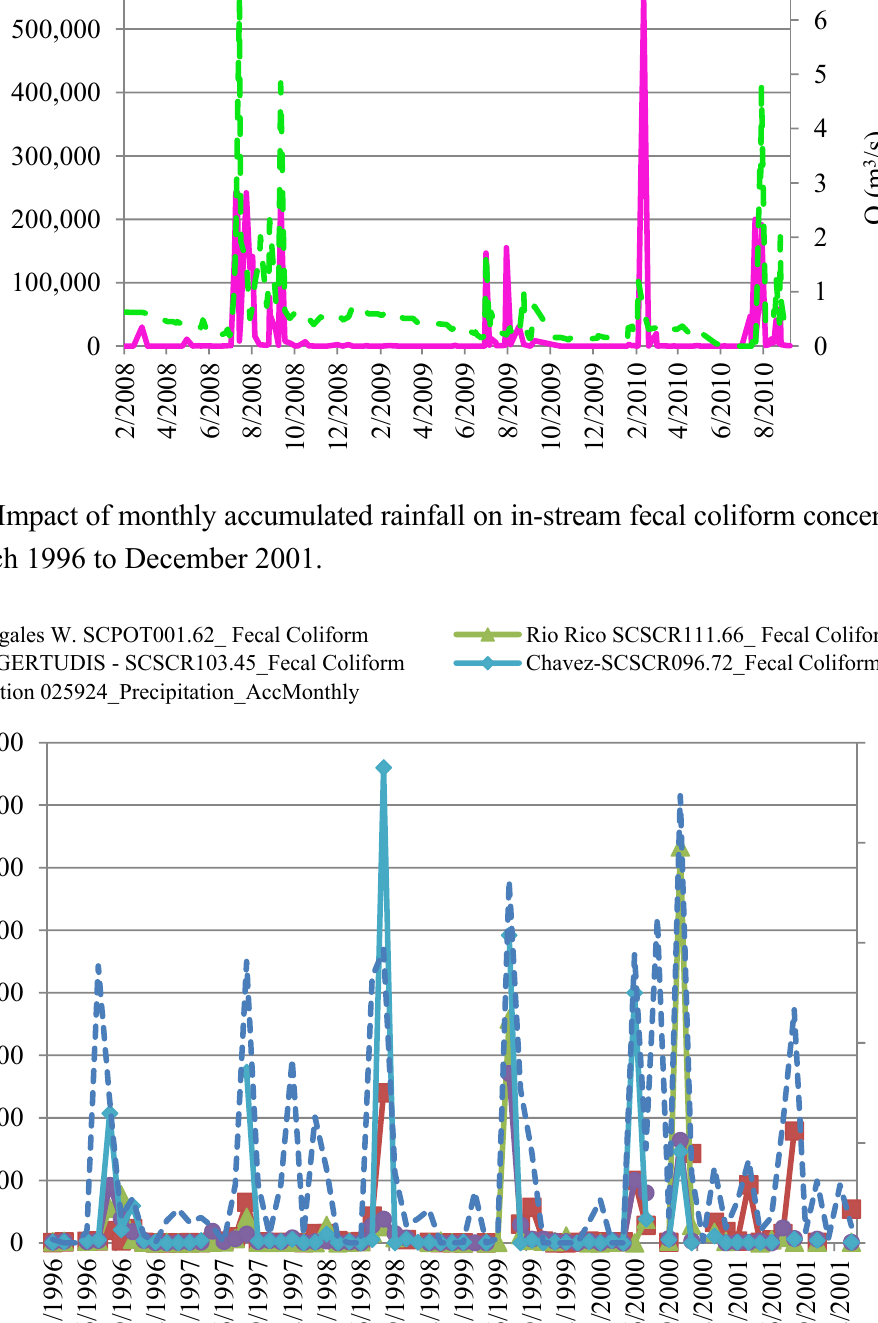
Figure 3. Mean in-stream E. coli concentrations in the Upper Santa Cruz River compared to daily streamflow at USGS station 9481740 from February 2008 to September 2010. The Arizona WQ standard for E. coli is 235 cfu/100 mL (FBC) and 575 cfu/100 mL (PBC) for a single sample maximum.